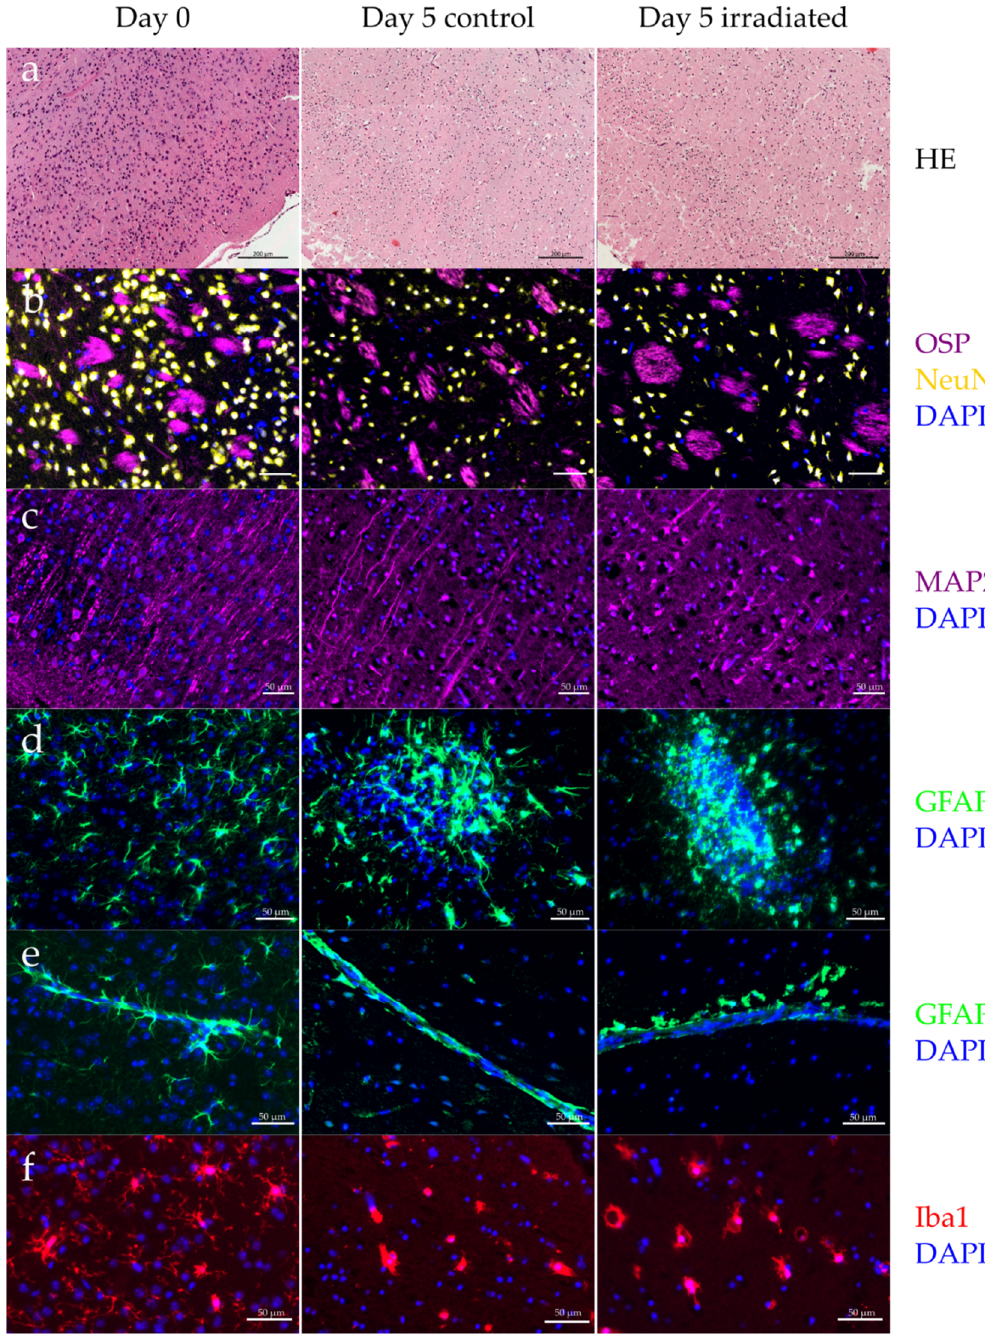
Figure 6. Cell type composition of organotypic brain slice culture after cutting, and at day 5 in culture for irradiated (10 Gy) and non-irradiated slices (24 h post irradiation). Both ( a ) H&E and ( b ) staining of neuronal nuclei (NeuN) revealed a shrunken cell morphology. Distribution of neurons (NeuN) and myelin (OSP) was unchanged, but ( c ) dendrite density (MAP2) decreased during cultivation. ( d ) Some astrocytes (GFAP) started uncontrolled proliferation, creating cell clusters. ( e ), ( f ) Loss of function was observed for astrocytes lining vessels and microglia (Iba1) in the tissue. Gamma H2AX foci formation following radiation revealed that OBSC responded to DNA damage, proving that cells were still metabolically active (Figure 7a). However, the typical spot-like formation of foci were largely absent, and foci evaluation could only be performed in a binary manner, i.e., cell nuclei positive or negative for γH2AX foci. Endogenous γH2AX expression was